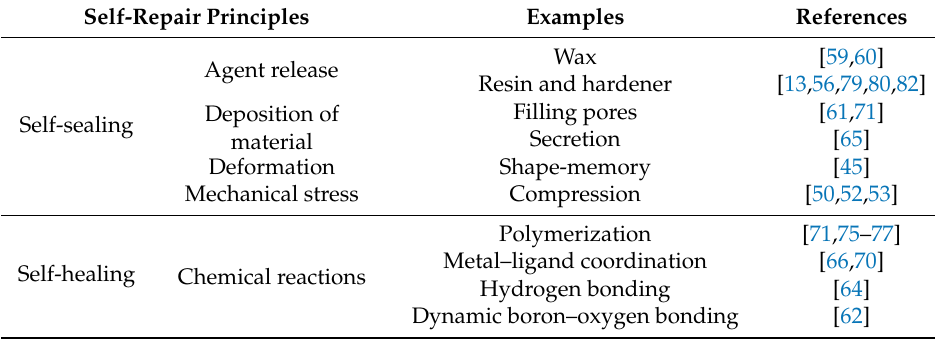
Table 6. Overview of bioinspired self-repair principles found in technical self-sealing and self- healing